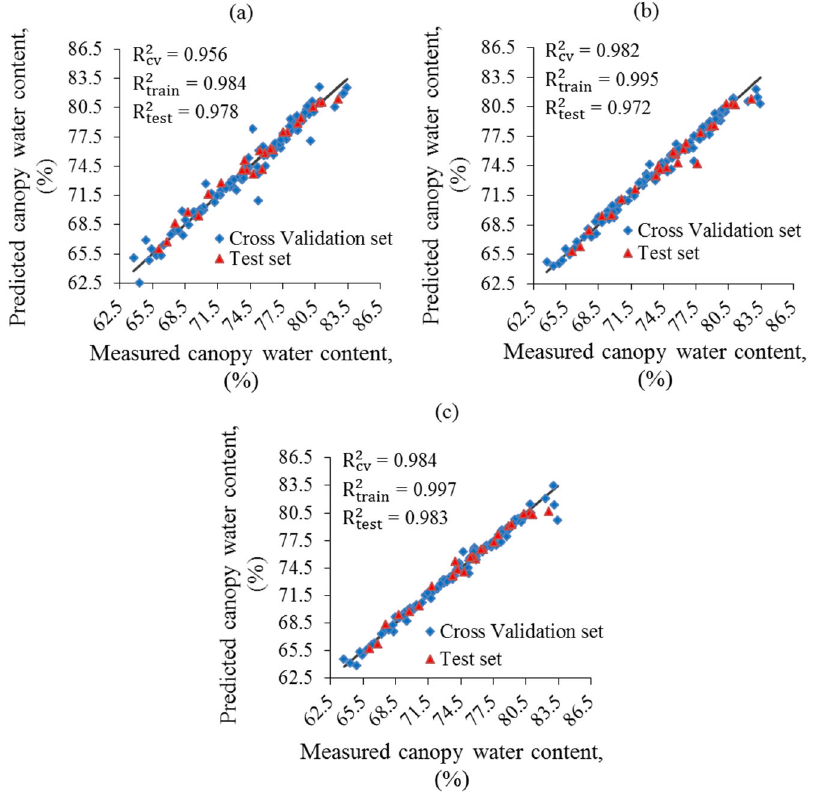
Figure 11. The relationship between expected and actual CWC values employing the best ‐ com ‐ bined features: ( a ) VI ‐ T ‐ 16, ( b ) GLCMF ‐ T ‐ 7, and ( c ) VI ‐ GLCMF ‐ T ‐